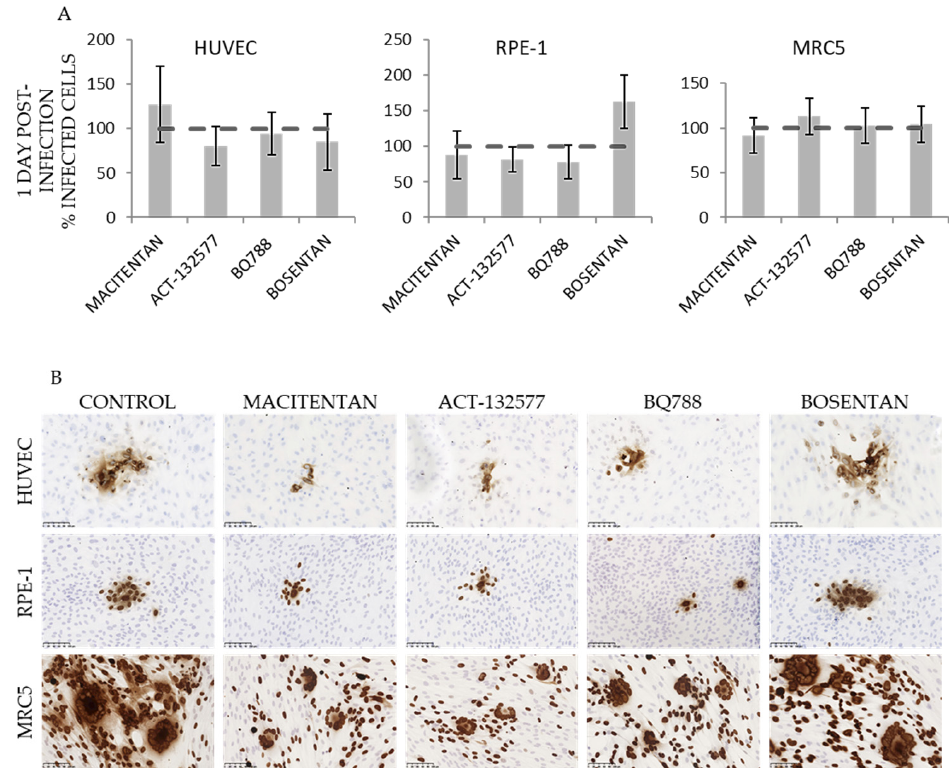
Figure 2. ETR antagonists prevent virion production. HUVECs, RPE-1 and MRC5 cells were treated with macitentan (12.5 µM for HUVEC, 25 µM for RPE and MRC5), ACT-132577 (6.25 µM for HUVEC, 12.5 µM for RPE and MRC5), BQ788 (25 µM), or bosentan (25 µM) and simultaneously exposed to HCMV. Infectivity was assessed by immunostaining for IE. ( A ) Number of IE-positive cells on day 1 post-infection normalized to infected, non-treated cells. ( B ) Representative images of HCMV-driven foci on day 5 after infection. Broken line corresponds to the level of IE expression in infected cells not treated with drugs. Scale bar 100 µM.